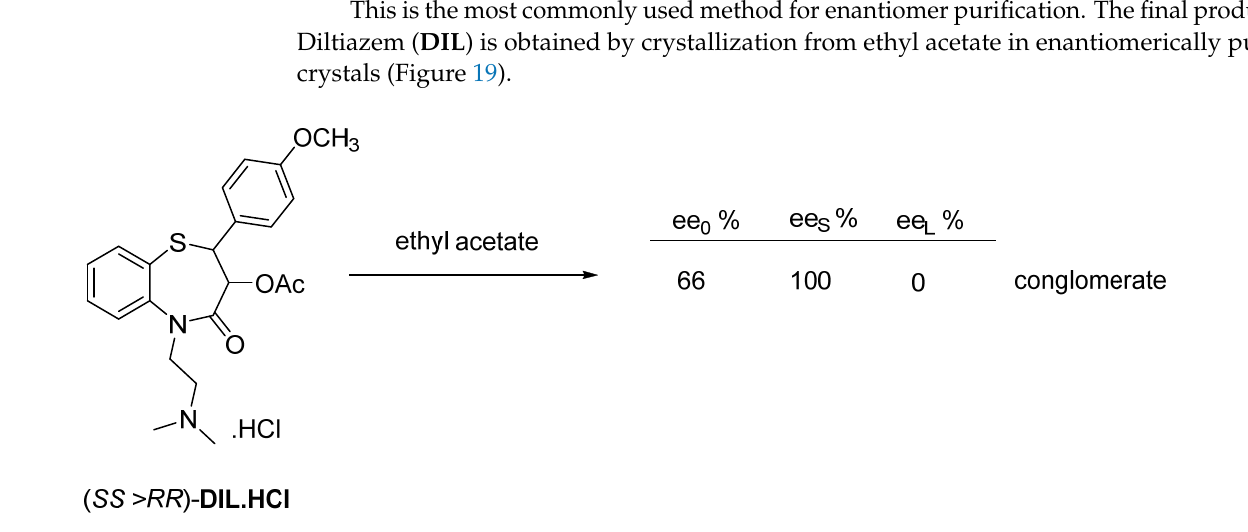
Figure 19. Crystallization of conglomerate former Diltiazem from ethyl acetate. Flumequine’s intermediate hydrochloride ( FTHQ . HCl ) can be purified from water as a racemate by crystallization (Figure 20).